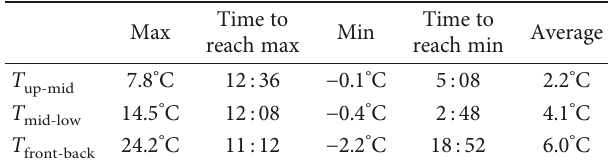
lower heat-absorbing aluminum plates and back of the insulation layer. Table 1: Summarized result of temperature di ff erence between the upper, middle, and lower of heat-absorbing aluminum plate and back of the insulation